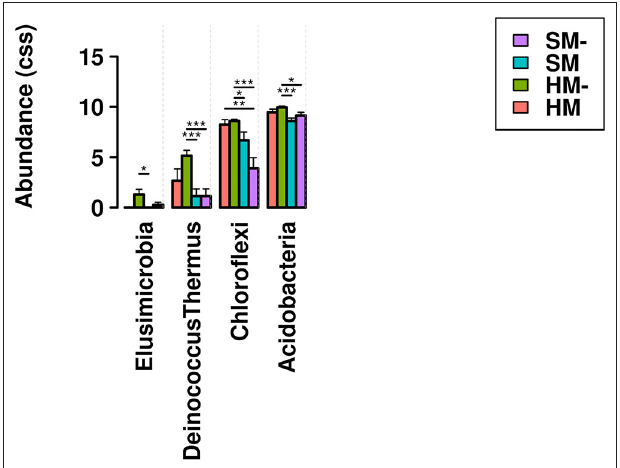
FIGURE 7 | Relative abundance of genera found to be differentially abundant in an ANOVA comparison of surface biocrusts with and without moss. Bars